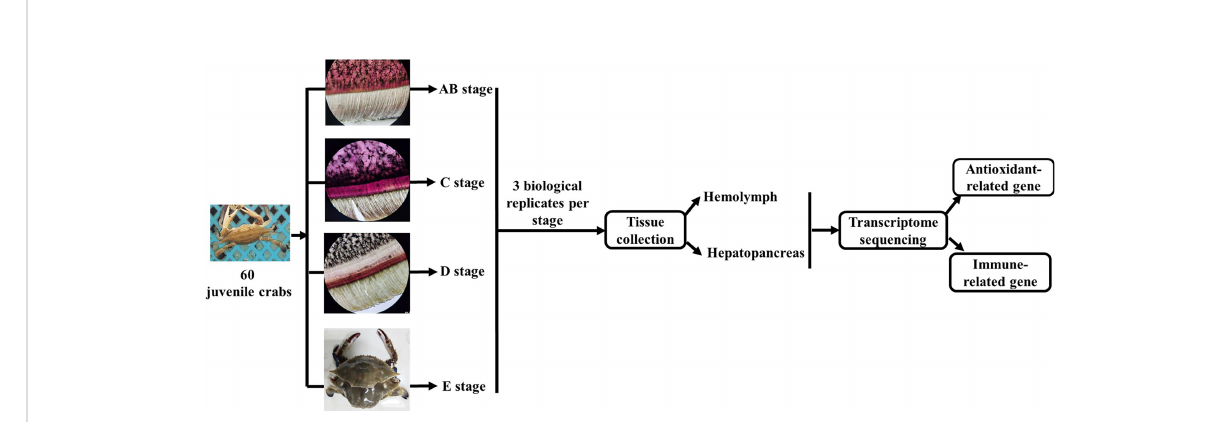
FIGURE 1 Schematic showing the experimental design and sampling procedures for the transcriptome analysis during the molting cycle of P. trituberculatus . Notes: The molting stage of P. trituberculatus was determined by observing the base of the swimming leg under a microscope before sampling. The characteristics of swimming leg bases in different molting stages of P. trituberculatus are shown in the fi gure. Stage AB: post-molt; stage C: inter-molt; stage D: per-molt; stage E: